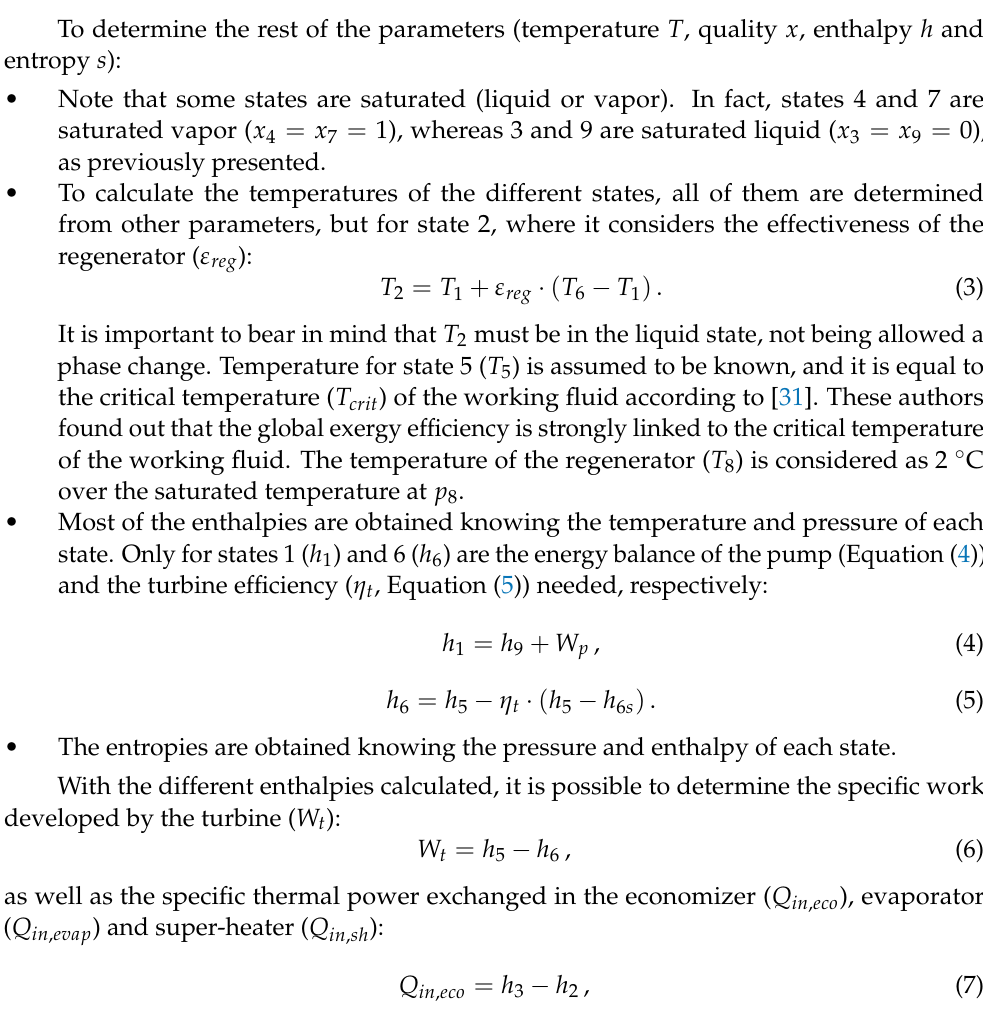
Figure 1. ORC cycle under analysis. ( a ) Elements; ( b ) T–s